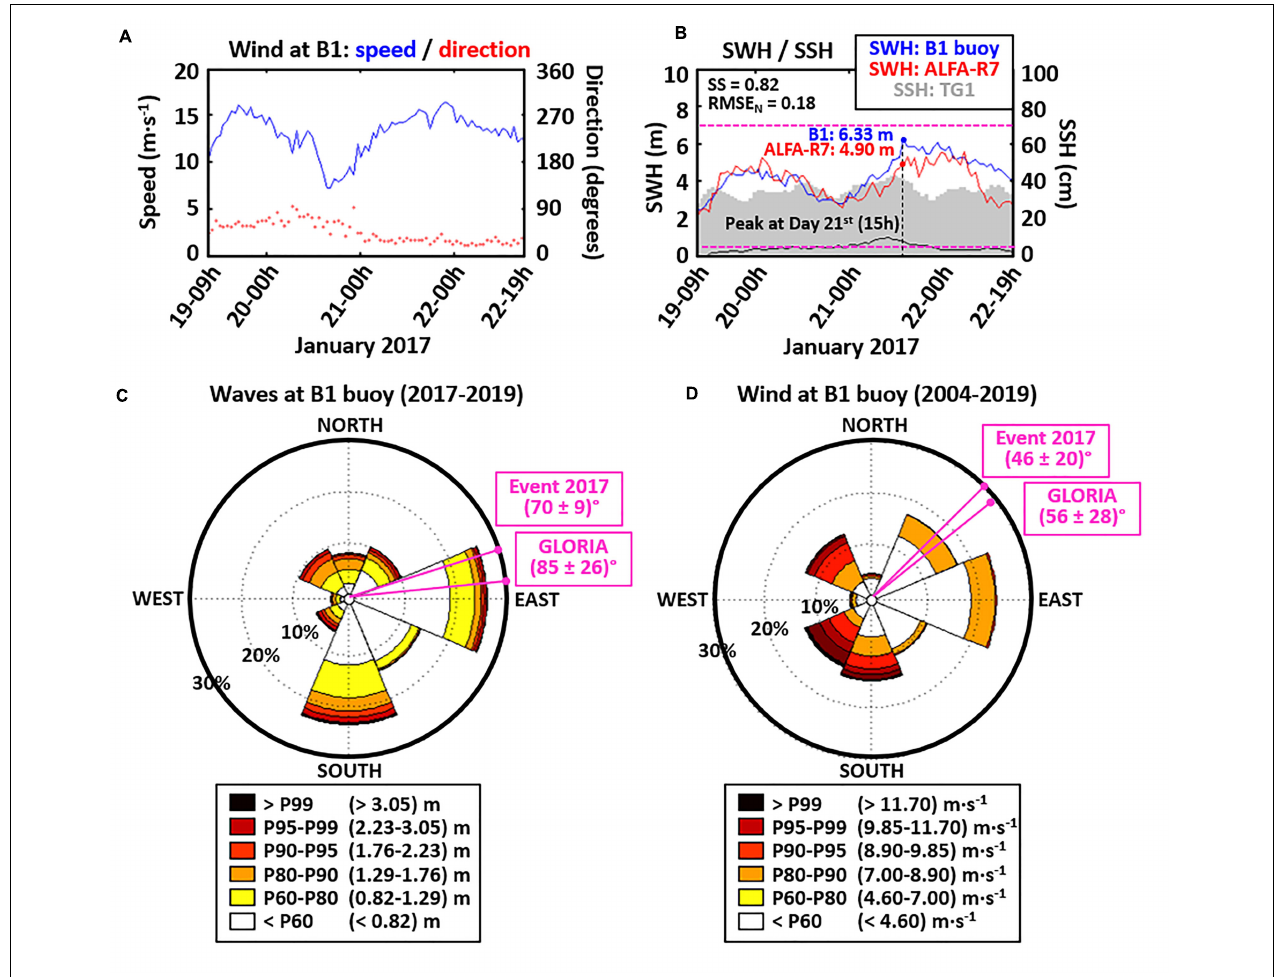
FIGURE 4 | (A) Wind speed (blue line) and direction (red dots) measured at B1 buoy during the severe event Jan2017 (3.5-day period); (B) Comparison of HFR-derived significant wave height (SWH) (provided by ALFA site: Arcs 4–9, R7 software) against hourly in situ observations from B1 buoy. Arcs 4–9 represents an average of wave estimations from all those range arcs. Gray columns and the black line represent the hourly sea surface height (SSH) and the meteorological tide recorded at TG1 tide-gauge, respectively. Pink dashed lines represent the lower and upper thresholds for SWH data collection; (C) Wave rose at B1 buoy for the 3-year period (2017–2019): SWH depicted by percentile intervals, incoming wave directions grouped each 45 degrees. The mean wave direction for each extreme event is denoted by a pink arrow; (D) Wind rose at B1 buoy for the 15-year historical period (2004–2019): wind speed depicted by percentile intervals, incoming wind direction grouped each 45 degrees. The mean wind direction for each extreme event is denoted by a pink